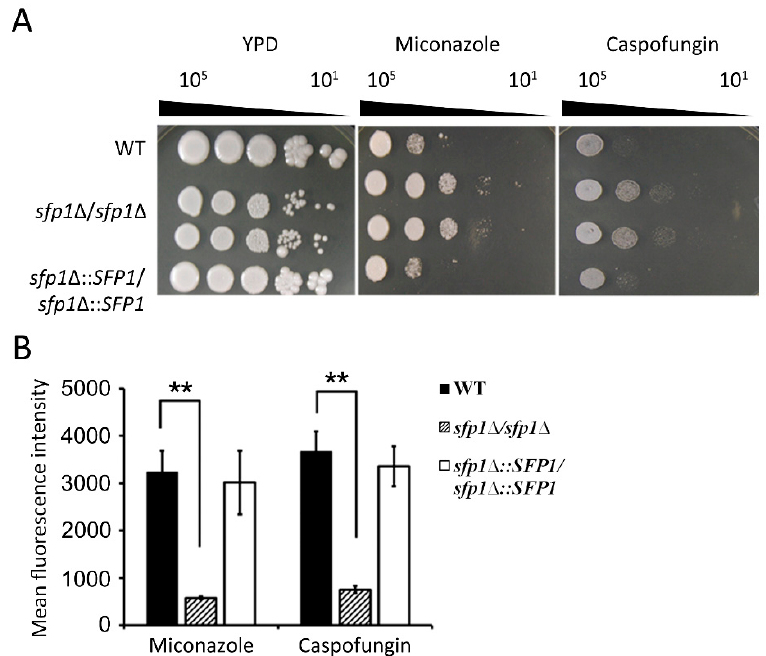
Figure 9. The effect of SFP1 deletion on cellular susceptibility to ROS-generating antifungals and the accumulation of intracellular ROS upon antifungal treatment. ( A ) One colony was inoculated into YPD medium and grown at 30 °C overnight. This culture was harvested by centrifugation and washed with sterile double-distilled water (ddH 2 O). Cells were ten-fold serially diluted and spotted onto YPD agar with or without 8 μ g/mL of an antifungal. The agar plates were incubated at 30 °C for 3 ‒ 4 d. Representative images of three independent experiments with identical results are shown. ( B ) Cells were treated with 3 μ g/mL miconazole or 1 μ g/mL caspofungin for 2 h. Intracellular ROS were measured using H 2 DCFDA staining and quantified by a flow cytometer. The results are presented as the mean ± standard deviation (SD) of three independent experiments. ** P < 0.01.